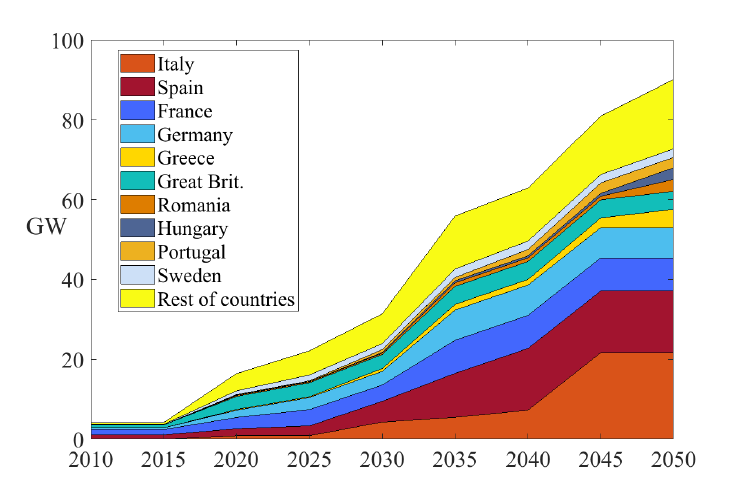
Figure 3. Total DR Capacity Evolution from 2010 to 2050 of top DR countries in GW. Table 1. 10 highest DR capacities in 2050 and initial DR capacity in 2015 together with other ratios. DR Capacity Country